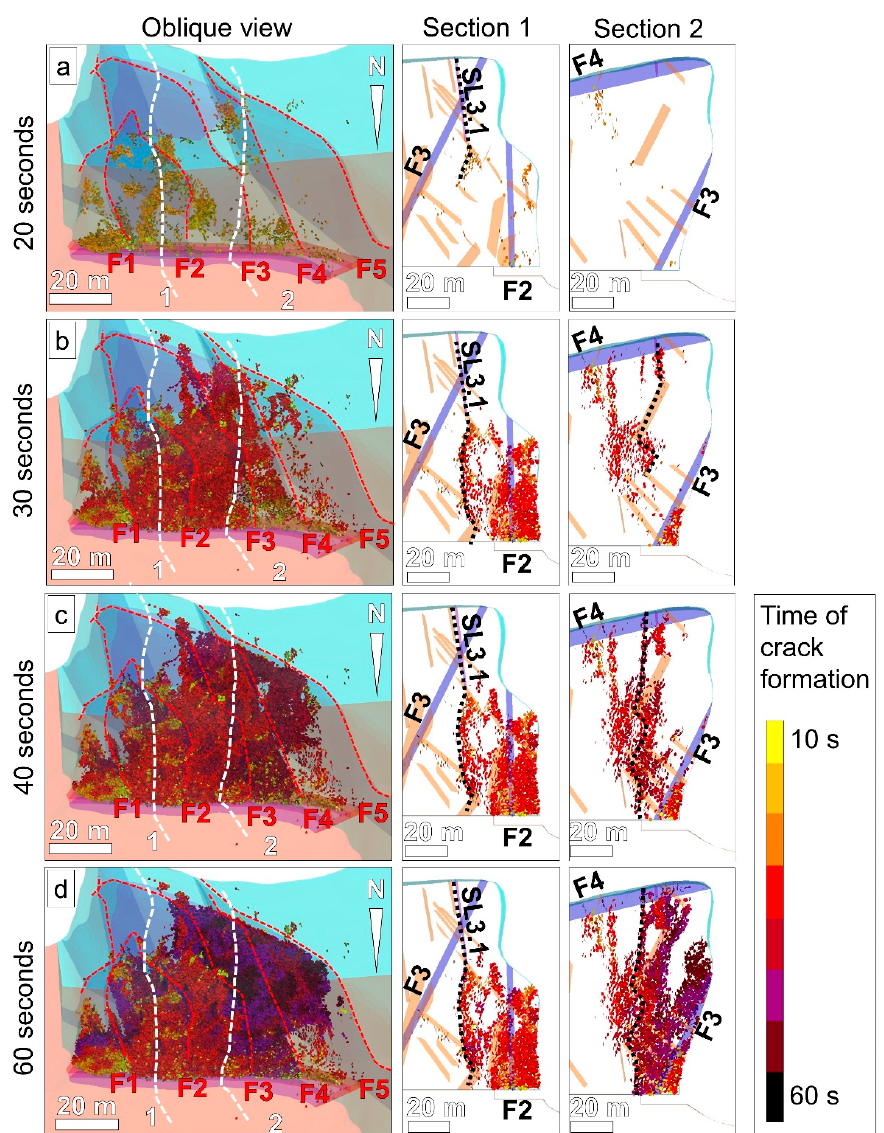
Figure 16. Simulated accumulation of brittle damage during the numerical modelling of the 2014 San Leo landslide. Red, dashed lines in the oblique views outline the first-order faults (F1–F5). White, dashed lines show the location of sections 1 and 2. The microcracks are color-coded based on the time of formation. In the sections, black, dotted lines outline the developing rupture surface. ( a ) microcracks simulated after 20 s (modelling time); ( b ) microcracks simulated after 30 s (modelling time). Note that the rear rupture surface is fully continuous in the eastern part of the slope (section 1); ( c ) microcracks simulated after 40 s (modelling time). Note the formation of a fully continuous rupture surface in the western slope (section 2); ( d ) microcracks simulated after 60 s (modelling time). Note the accumulation of brittle damage behind the rupture surface, particularly in the western part (section